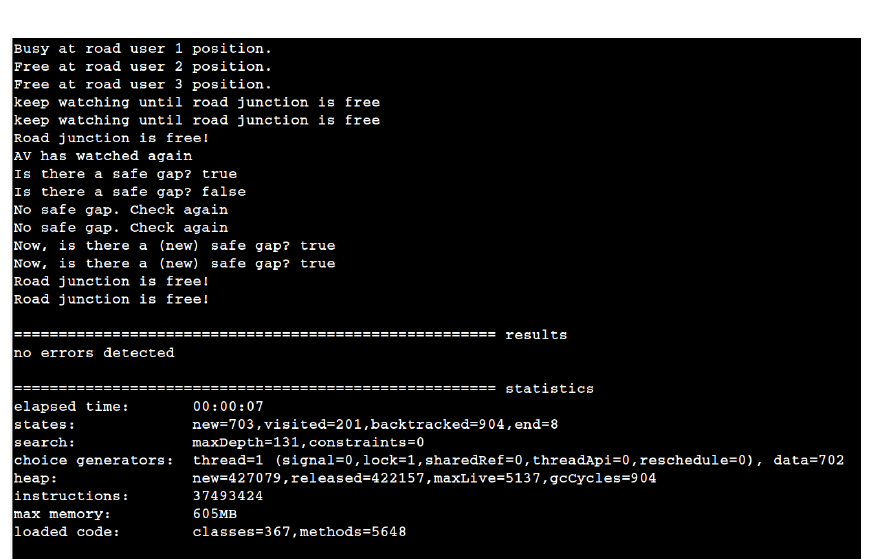
Figure 9. Execution log of ap12